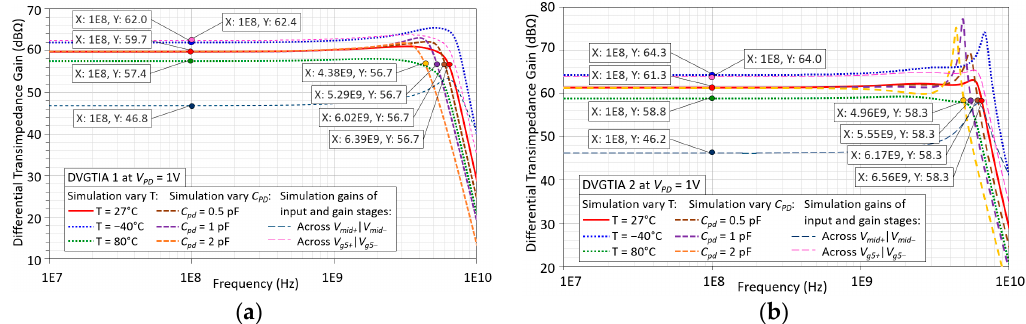
Figure 13. ( a ) Reliability testing in post-layout simulation by increasing C pd and varying temperature as well as di ff erential gain across V mid and V g 5 for DVGTIA design 1 and ( b ) DVGTIA design 2.